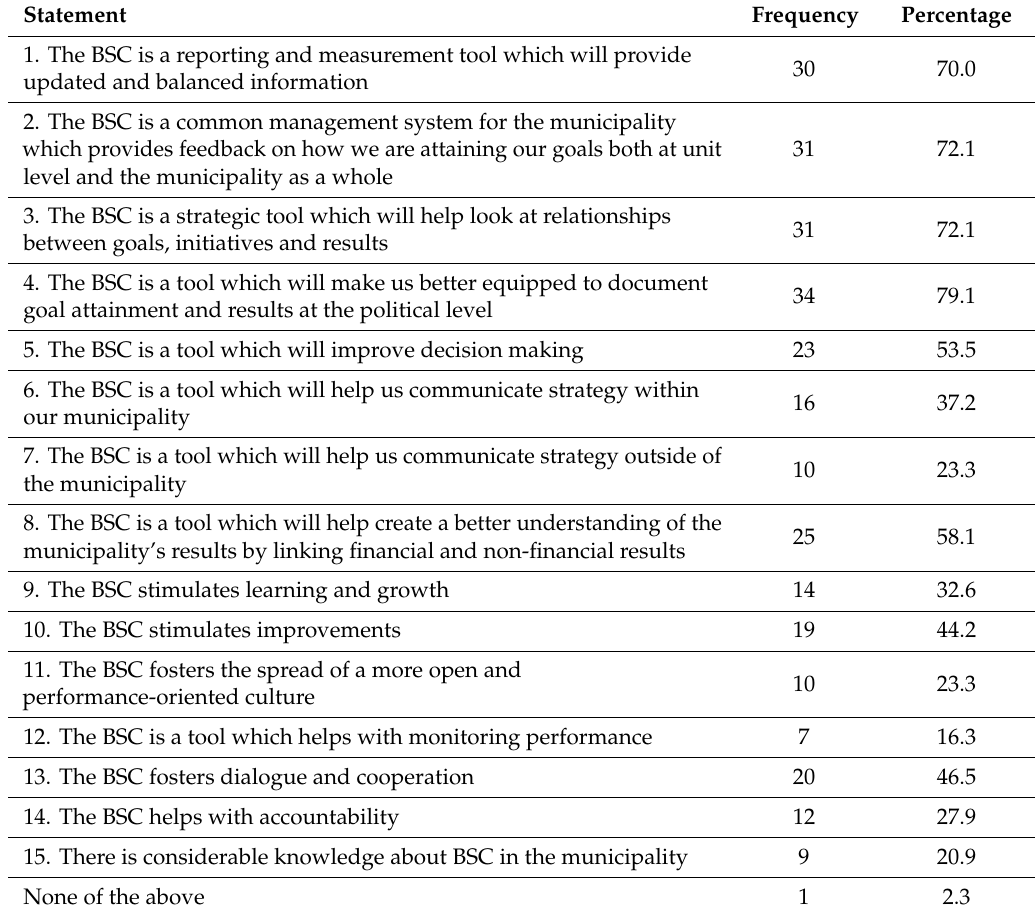
Table 16. Reasons for BSC adoption (N = 43).